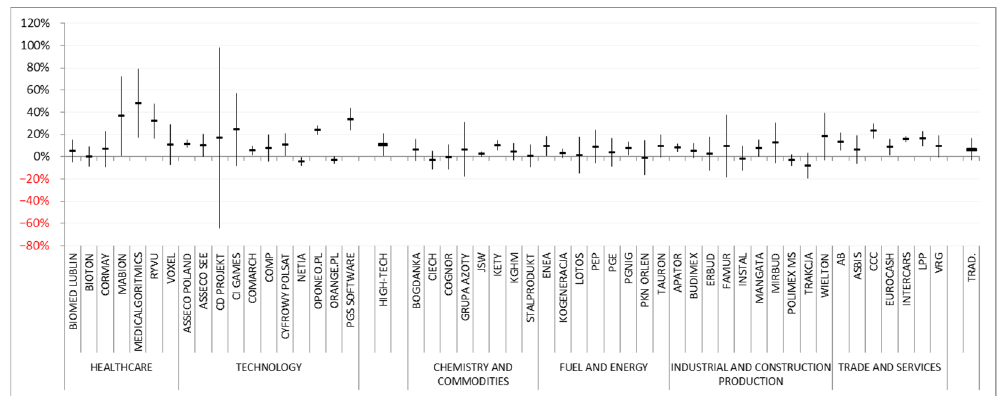
Figure 7. A typical area of variation of operating costs in the surveyed enterprises . Source: own work.